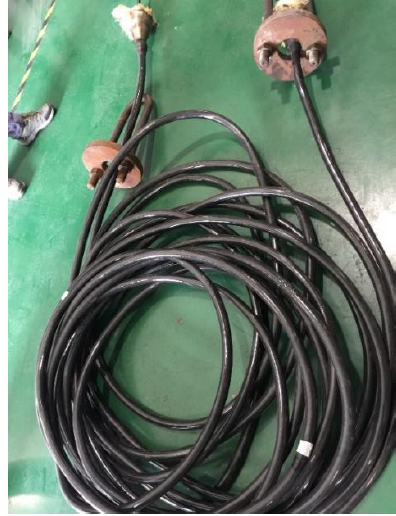
Figure 19. Appearance of the EOM cable. Table 2. Properties of the EOM cable.